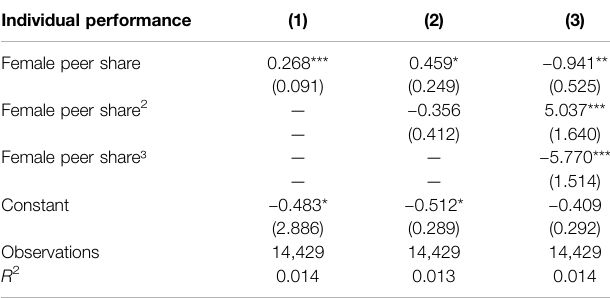
TABLE 2 | Regression results for within-ranks effects for men. Individual performance